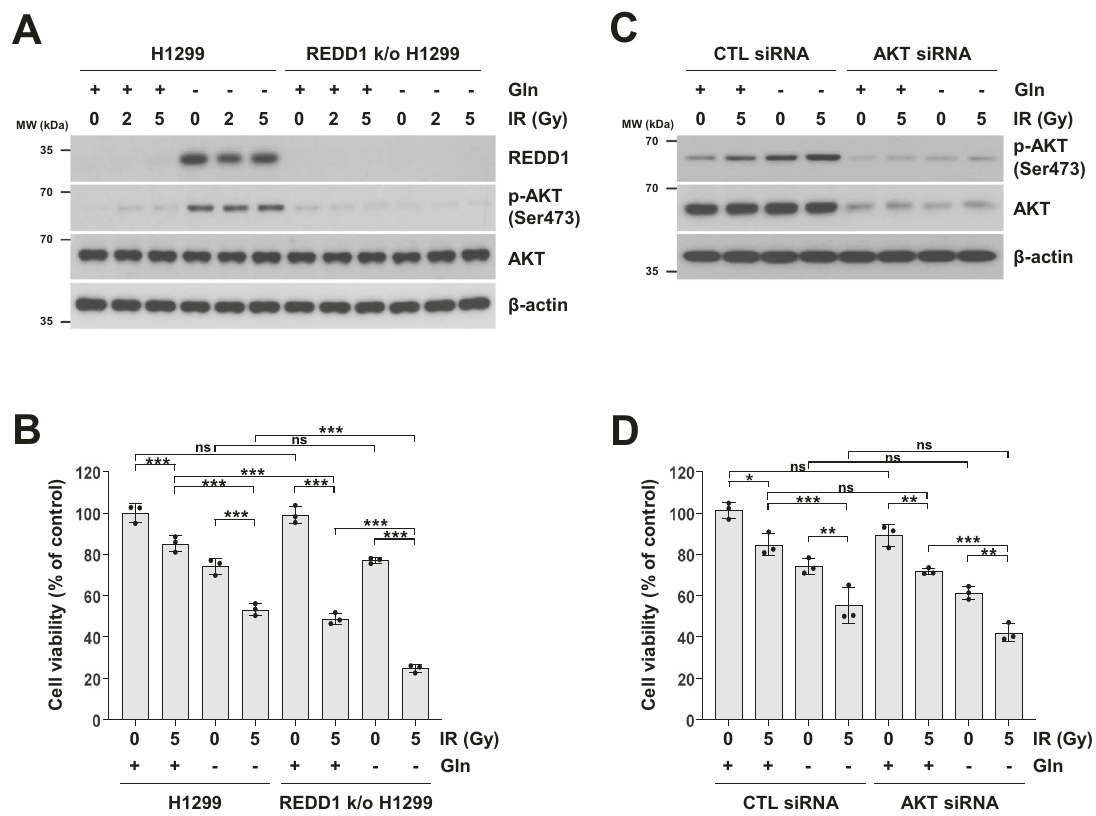
Fig. 8 Disruption of REDD1 or AKT activity enhances cell sensitivity to ionizing radiation in glutamine-deprived cells. A , B H1299 and CRISPR/Cas9-mediated REDD1-knockout H1299 cells were exposed to the indicated dose of IR in the presence or absence of glutamine for 24 h. C , D H1299 cells were transiently transfected with a control or AKT siRNA for 12 h and subsequently exposed to 5 Gy of IR in the presence or absence of glutamine for 24 h. The levels of the indicated proteins were measured by western blot analysis ( A , C ). Cell viability was measured by MTT assay ( B , D ). The data are presented as the mean percentage of control ± SD relative to the control ( n = 3; * p < 0.05; ** p < 0.01; *** p < 0.001; ns, not signi fi cantly different). CTL: control, IR: ionizing radiation. REDD1 induction and mTORC1 inhibition in response to amino acid deprivation. Inhibition of REDD1 expression using siRNA prevented mTORC1 inhibition caused by glutamine or arginine deprivation, indicating that REDD1 induction is required for mTORC1 inhibition under amino acid deprivation. These data suggest that REDD1 is a critical effector of GCN2/ATF4 signaling and is required to sustain mTORC1 inhibition triggered by amino acid deprivation.